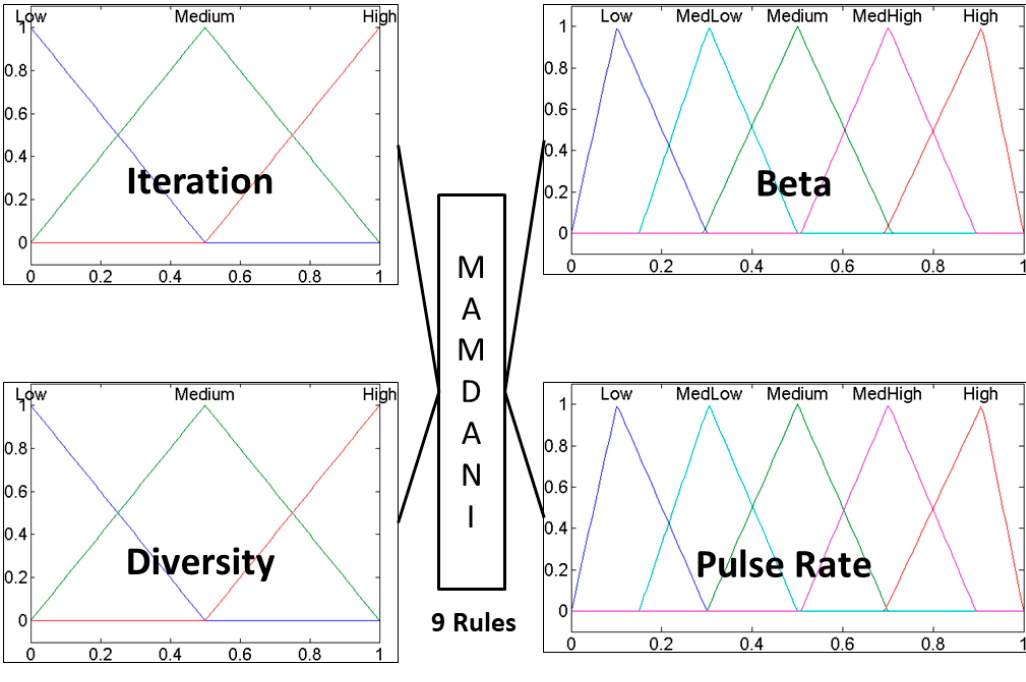
Figure 5. Type-1 Fuzzy System.